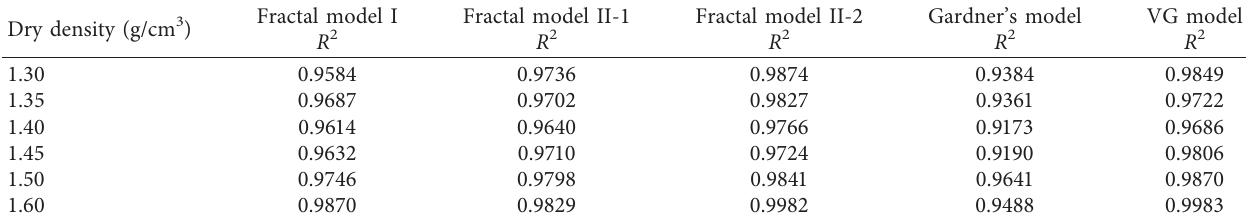
Table 3: Correlation coefficients R 2 determined by model fitting.